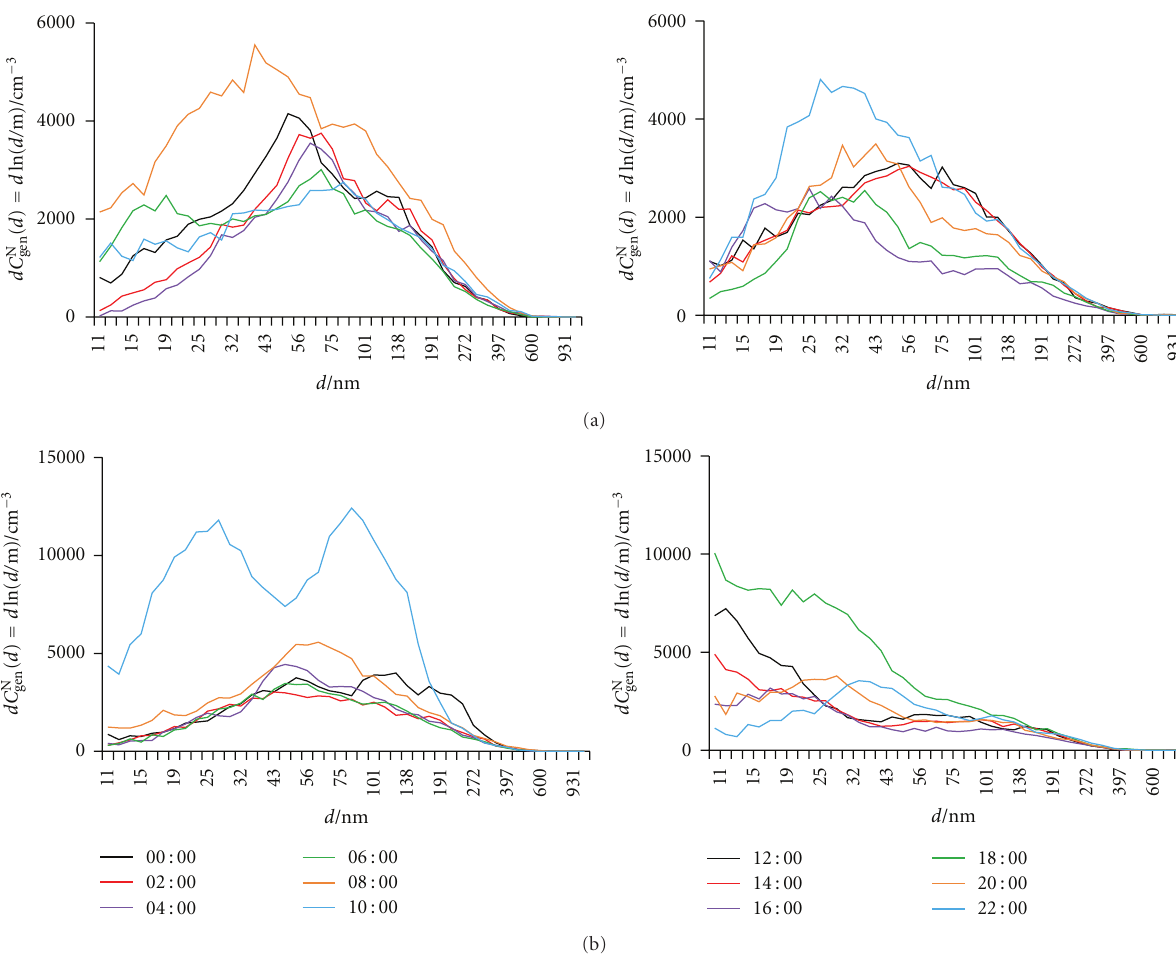
(d) = dln( d/ m)) in outdoor air recorded every two hours on: (a) May 21 and (b) May gen